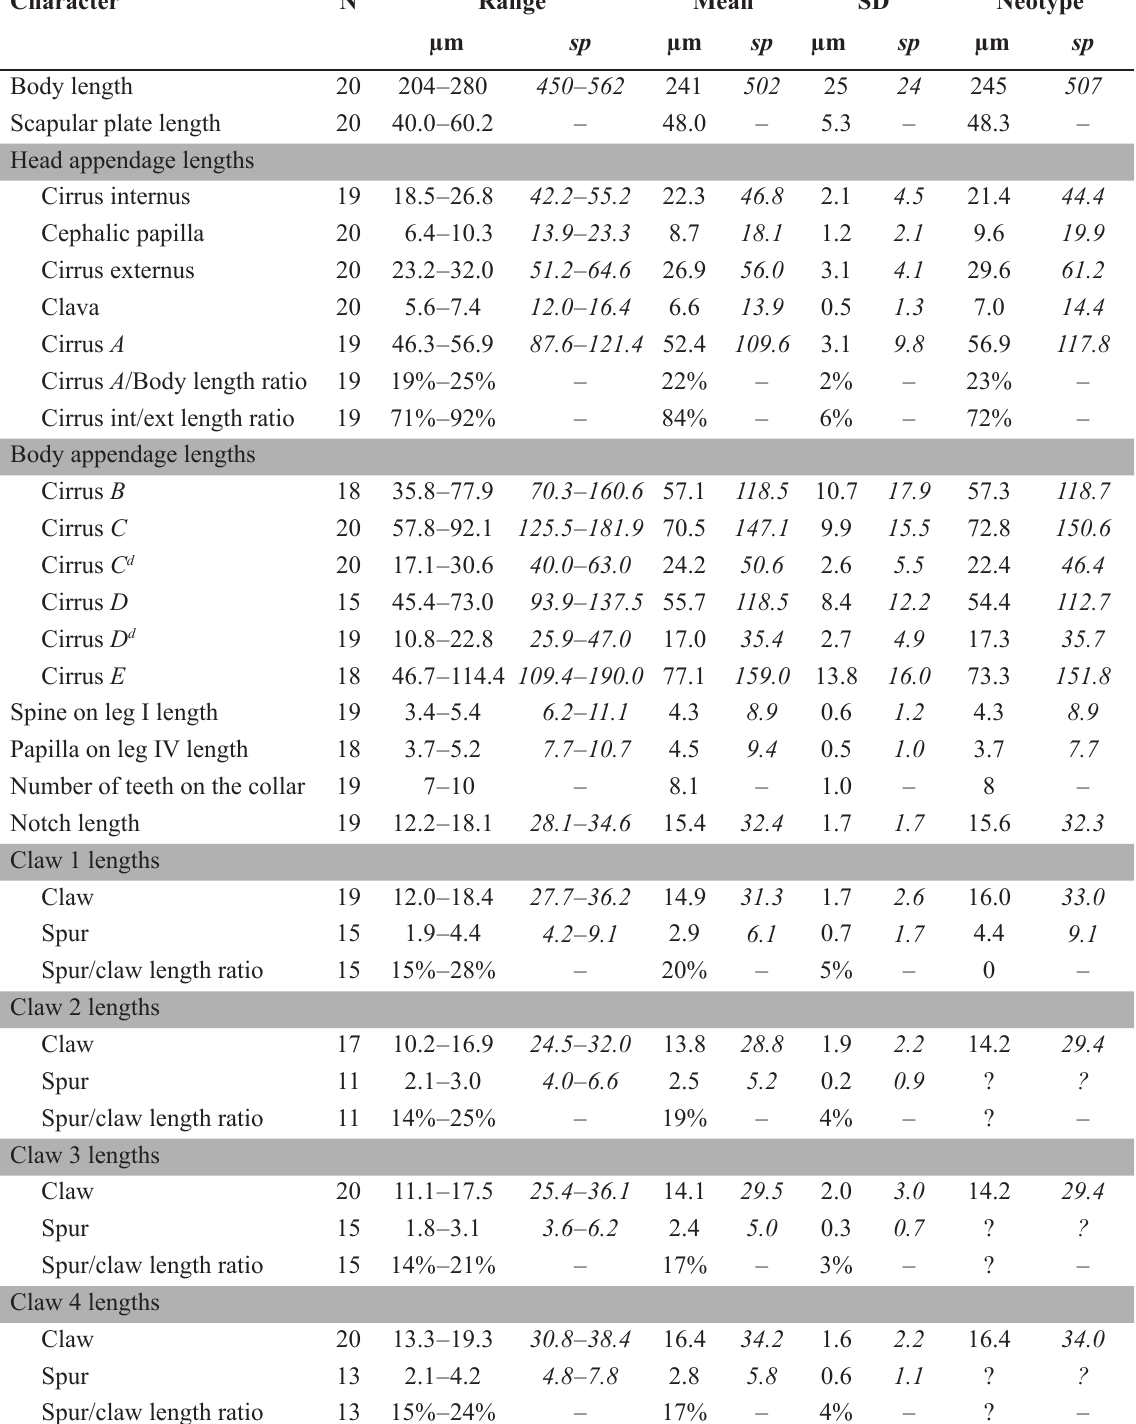
Table 1. Measurements (in µm) and sp values of selected morphological structures of adult females from the neotype population of Echiniscus q. quadrispinosus Richters, 1902 mounted in Hoyer’s medium. Abbreviations: N = number of specimens/structures measured; RANGE = refers to the smallest and the largest structure among all measured specimens; SD = standard